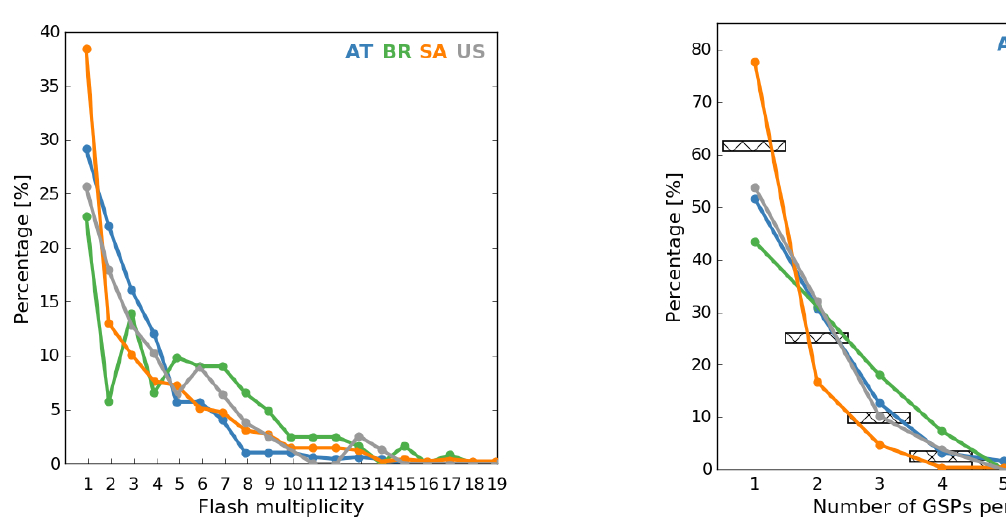
Figure 1. Distribution of the number of strokes per flash. Figure 2. Distribution of the number of GSPs per flash. The shaded rectangles represent the result for the combined data